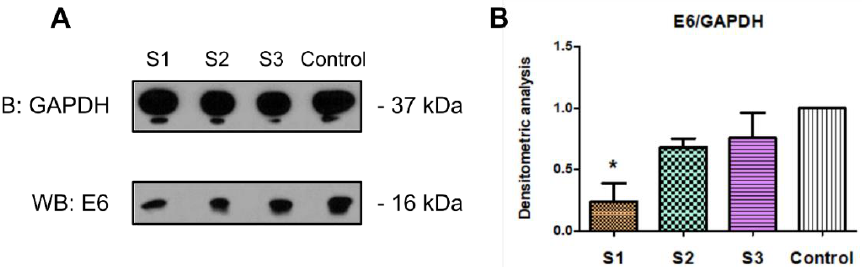
Figure 7. Influence of crude C. majus latex (S1), protein fraction (S2), and alkaloid-rich fraction (S3) on the expression of the viral E6 oncogene at the protein level in HeLa cells. Non-toxic concentrations of crude latex, alkaloid-rich fraction, and protein fraction were administered on HeLa cells. After 48 h of incubation, proteins were isolated, which were then separated by SDS-PAGE. Immunodetection of the E6 protein and the GAPDH as a reference protein was performed using the Western blot and specific antibodies. The densitometric measurement showed that the crude C. majus latex decreased the level of HPV E6 protein the most (reduction by 76.3%). Moreover, the protein fraction lowered the level of E6 protein by 32.1% and the alkaloid-rich fraction by 24.5%. S1—cells treated with crude latex, S2—cells treated with the protein fraction, S3—cells treated with the alkaloid-rich fraction, Control— untreated cells. ( A ) Representative Western blot of protein immunodetection. ( B ) Densitometric analysis of signals from protein fractions using ImageJ (NIH) software. * p < 0.05.